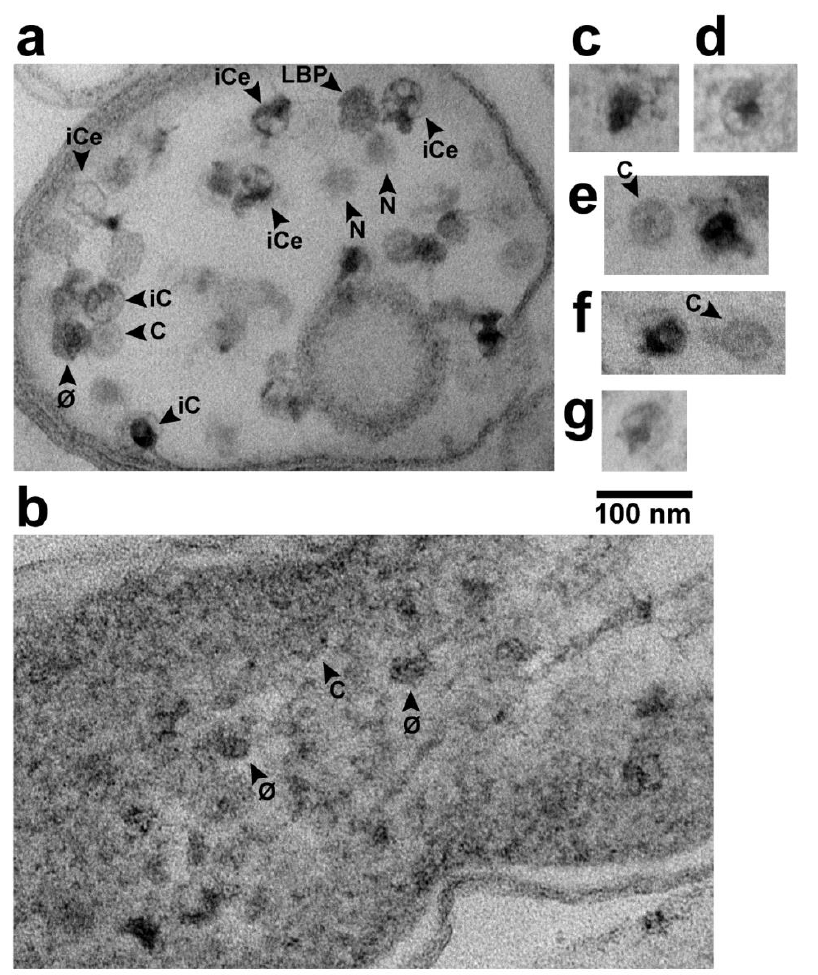
Figure 3. Phage assembly-generated particles seen in different contexts by in-plaque EM-TS. ( a ) the interior of a sub-cellular vesicle generated by cellular lysis and loss of cytoplasmic content, ( b ) the interior of an infected cell that has retained its cytoplasm with an end of the DNA-containing nucleoid at the upper right corner, ( c – g ) selected capsids with a hyper-expanded shell. Uranyl acetate/lead staining was used. ϕ , phage; C, capsid; iC, capsid with internal DNA; iCe, capsid with internal and external DNA; LBP, larger-than-phage black particle; N, LBP or ϕ , with equator not in the section.